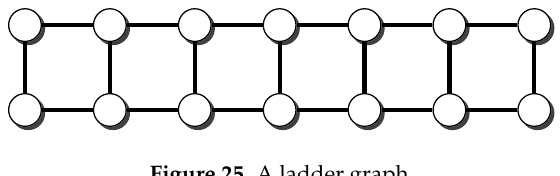
Figure 25. A ladder Figure 17: A ladder graph.